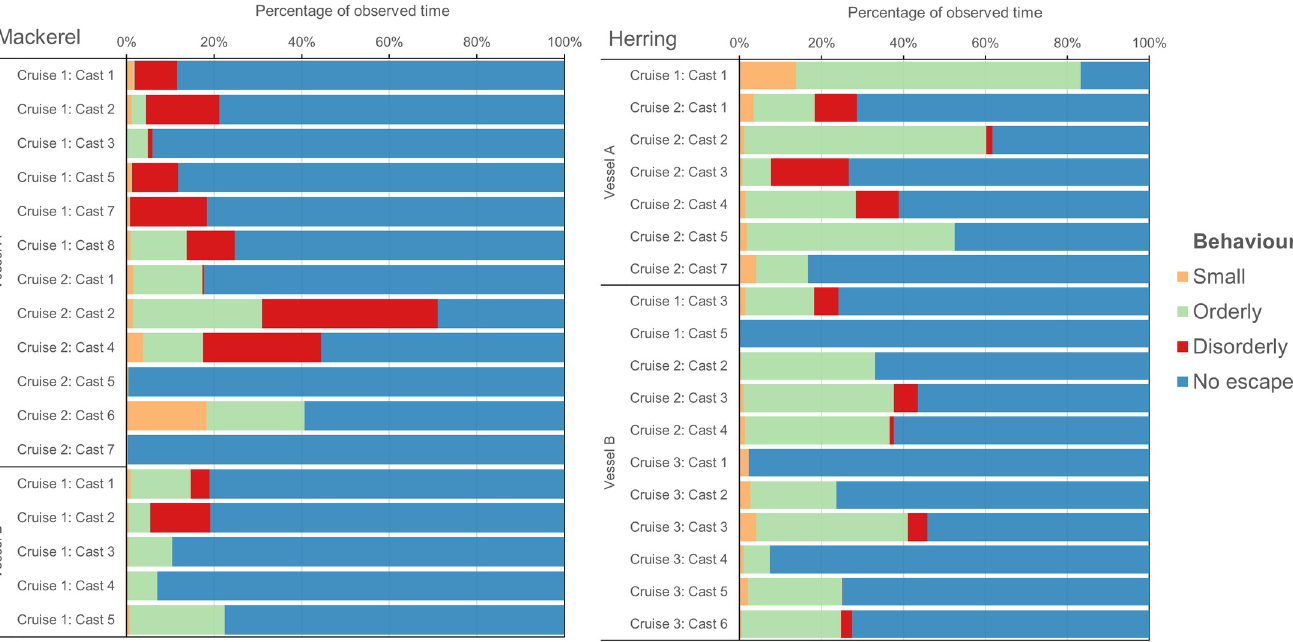
Fig 4. Behavioural time budget. The behavioural time budget of mackerel and herring whilst escaping from purse seines, from different slipping events (casts) from two different vessels.